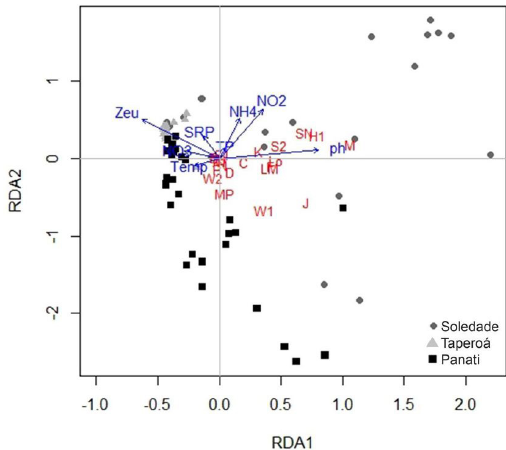
Figure 6. Ordination of the Redundancy Analysis (RDA) axes applied to the eight abiotic variables and 21 biotic variables (functional groups) of the Soledade and Taperoá reservoirs and Panati lagoon from November 2005 to December 2010. Sampling sites with missing data (nutrients - Jul/2009 to Dec/2010) in the Soledade reservoir were removed from the analysis. Legend: Temp (water temperature), Zeu (euphotic zone), NO3 (nitrate), NO2 (nitrite), NH4 (ammonium), SRP (soluble reactive phosphorus), TP (total phosphorus), ph